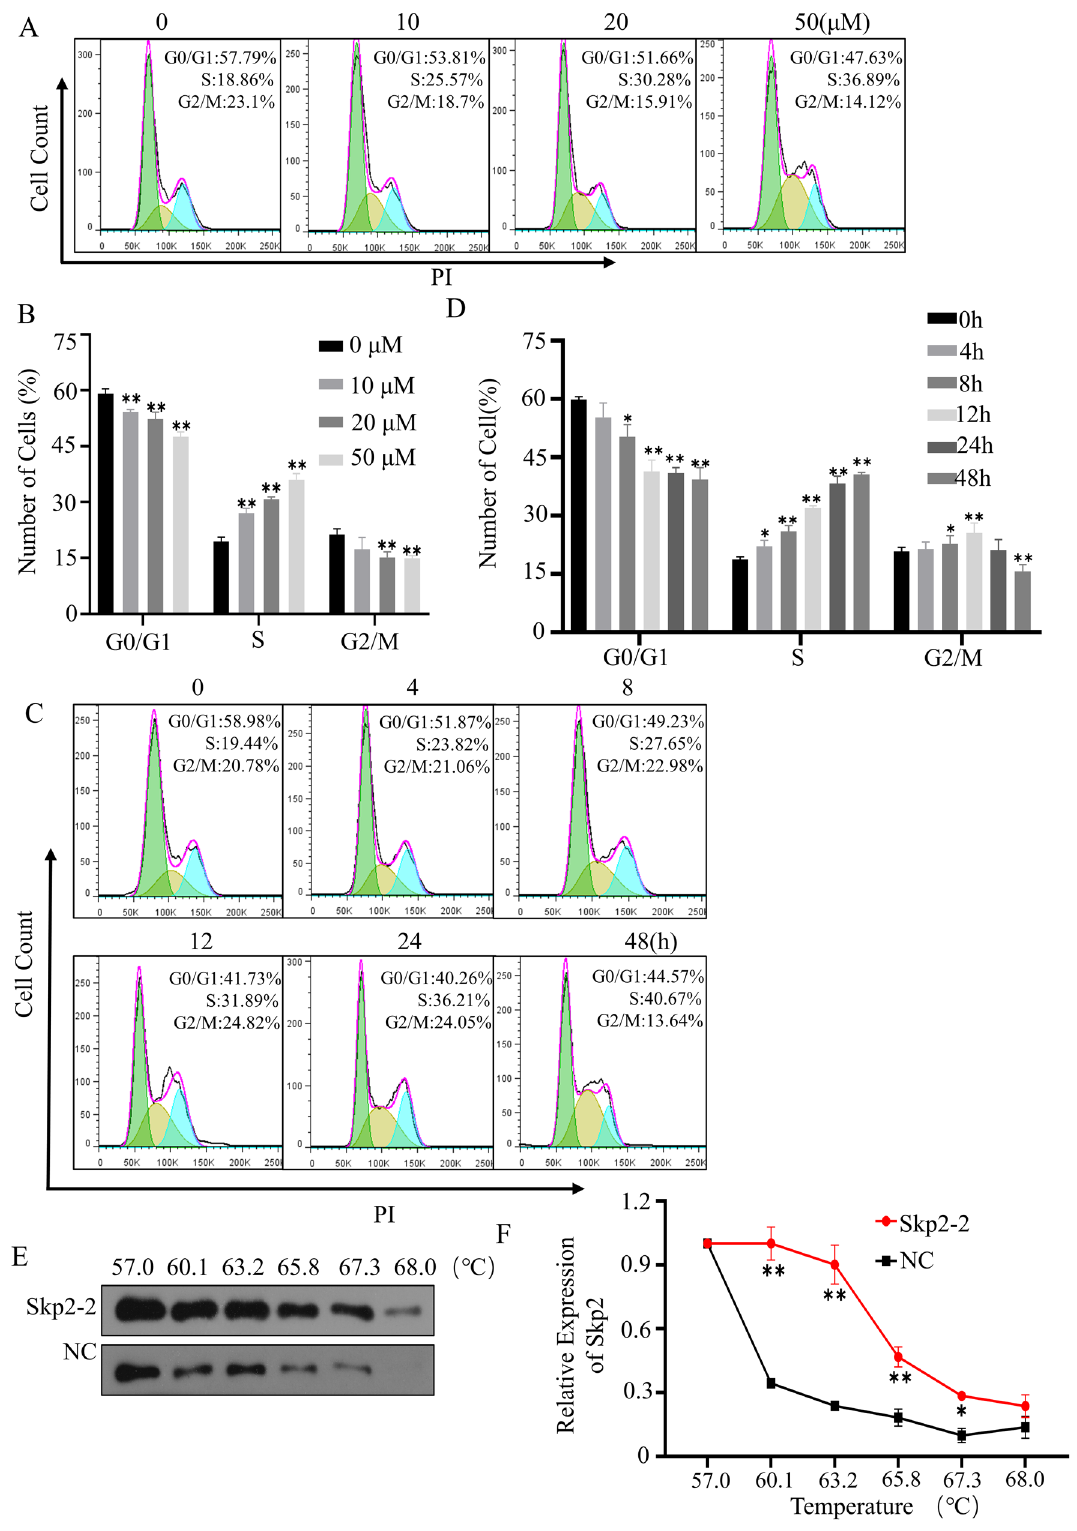
Figure 5. Skp2-2 inhibits cell cycle progression in SGC-7901. ( A , B ) SGC-7901 cells treated with increasing concentrations of Skp2-2 for 48 h. ( C ) ( D ) SGC-7901 cells treated with 50 μM Skp2-2 for 0–48 h. Fixed cells were collected and the cell cycle was measured by flow cytometry. ( E , F ) SGC-7901 cells treated with 50 μM Skp2-2 for 4 h, the stability of protein Skp2 was measured at different temperatures. The representative data of at least three independent experiments are shown, * P < 0.05, ** P < 0.01. compared with the control group (mean ± SD, n =